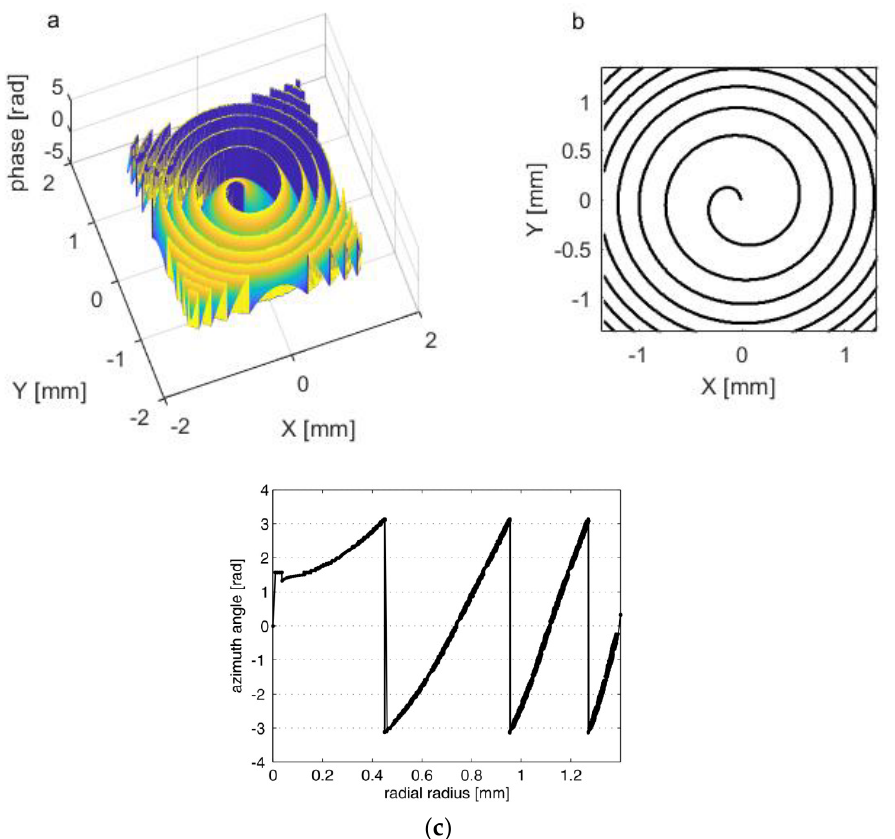
Figure 3. ( a ) Phase distribution of the Laguerre–Gauss (LG) beam (m = 1), phase values plotted modulo-2 π . Edge in this figure is 2 π phase jump; ( b ) Points assigned to the 2 π phase jump detected by Roberts algorithm for edge detection; ( c ) Spiral line from (b) expressed in polar coordinates. Unwrapping is needed to get the correct values of azimuth angle φ .